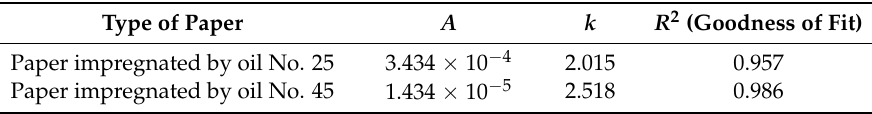
Figure 2. Relationship between DP and volume resistivity. Table 1. Fitting information (Fitting equation: ρ = A × DP k ).